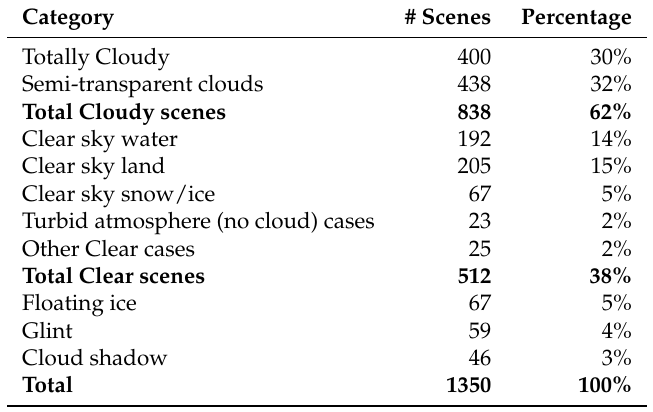
Table 2. Distribution of the labelled scenes in the gold standard dataset provided to all the participants in PROBA-V Round Robin